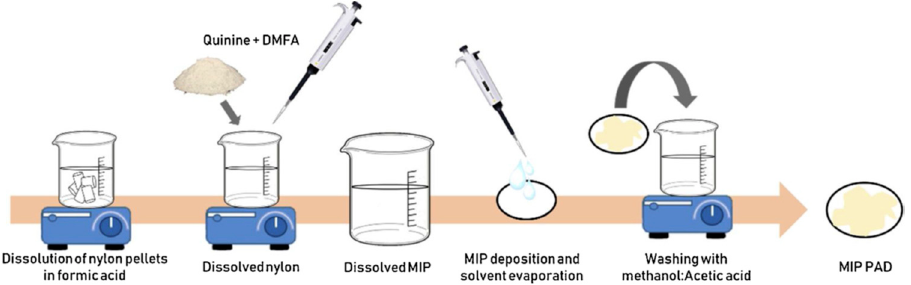
Figure 17. Diagram of the different steps of the synthesis of molecularly imprinted polymer PADs, namely, dissolution of nylon pellets in formic acid, addition of quinine and DMFA, MIP deposition and solvent evaporation, and washing with methanol-acetic acid solution and water prior to drying. Reprinted from [61], with permission from Elsevier, 2019.